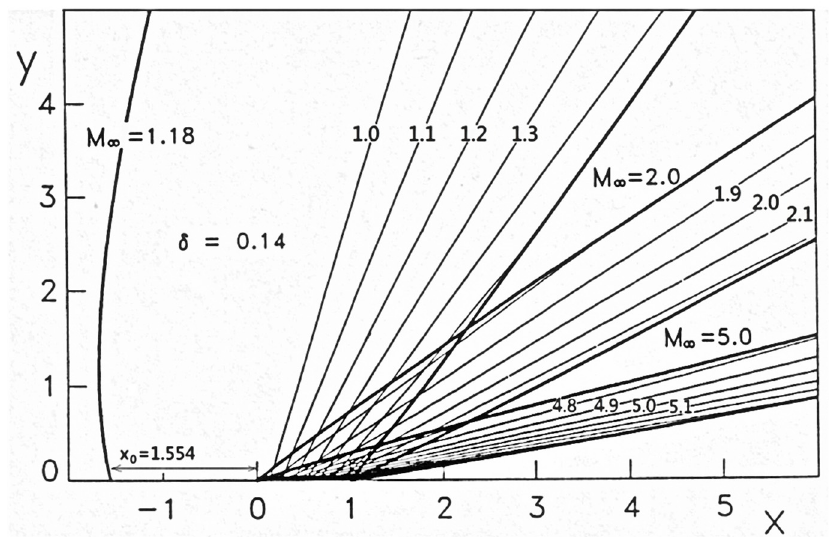
Figure 4. The iso-Mach lines and shock waves of a parabolic airfoil with δ = 0.14 subject to supersonic ( M (cid:2998) = 2.0 ), transonic ( M (cid:2998) = 1.18 ), and hypersonic ( M (cid:2998) = 5.0 ) far fields.